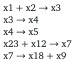
Snippets of a model of the MAPK cascade that uses variable names that impair readability.